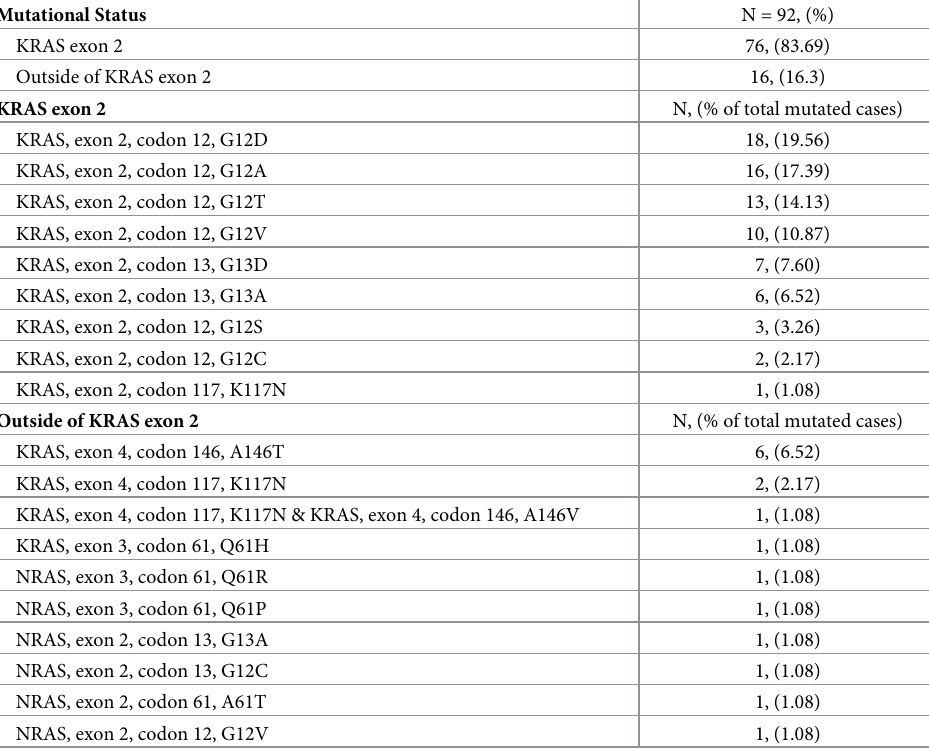
Table 2. Mutational status and detailed mutation classes